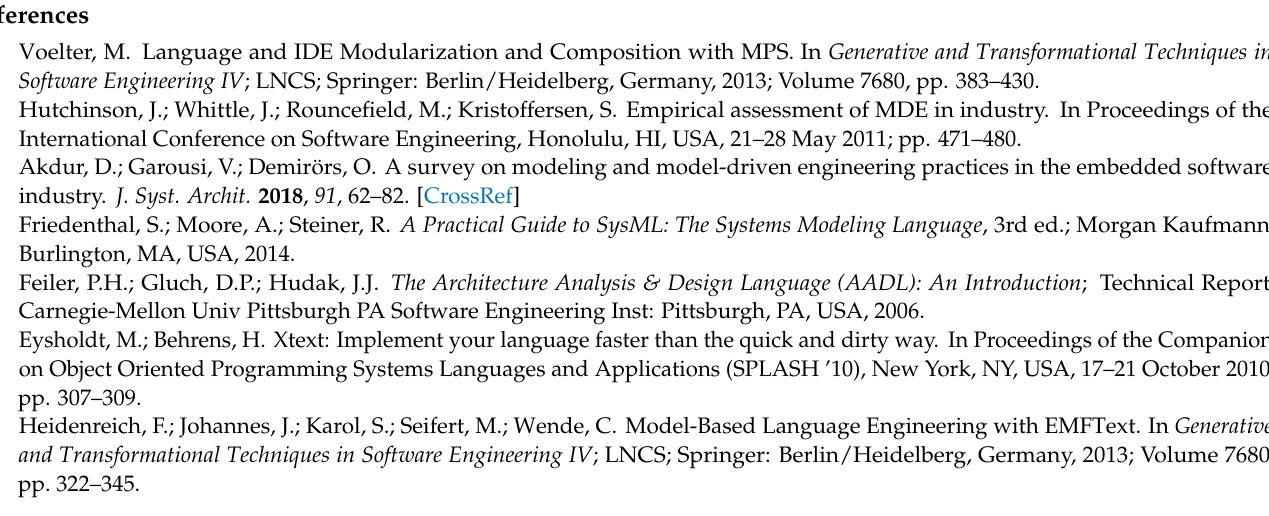
Figure A1. The Meta-Grammar